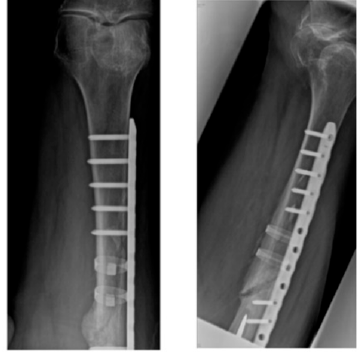
Figure 1. Internal plate-screw fixation.